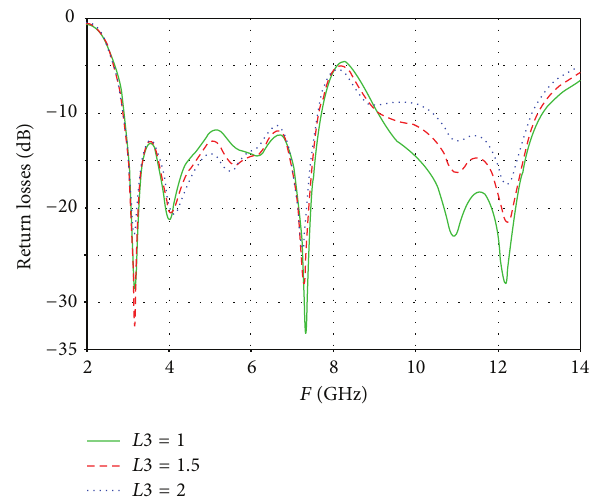
Figure 5: Simulated return losses of the proposed UWB antenna with different 𝑆 .